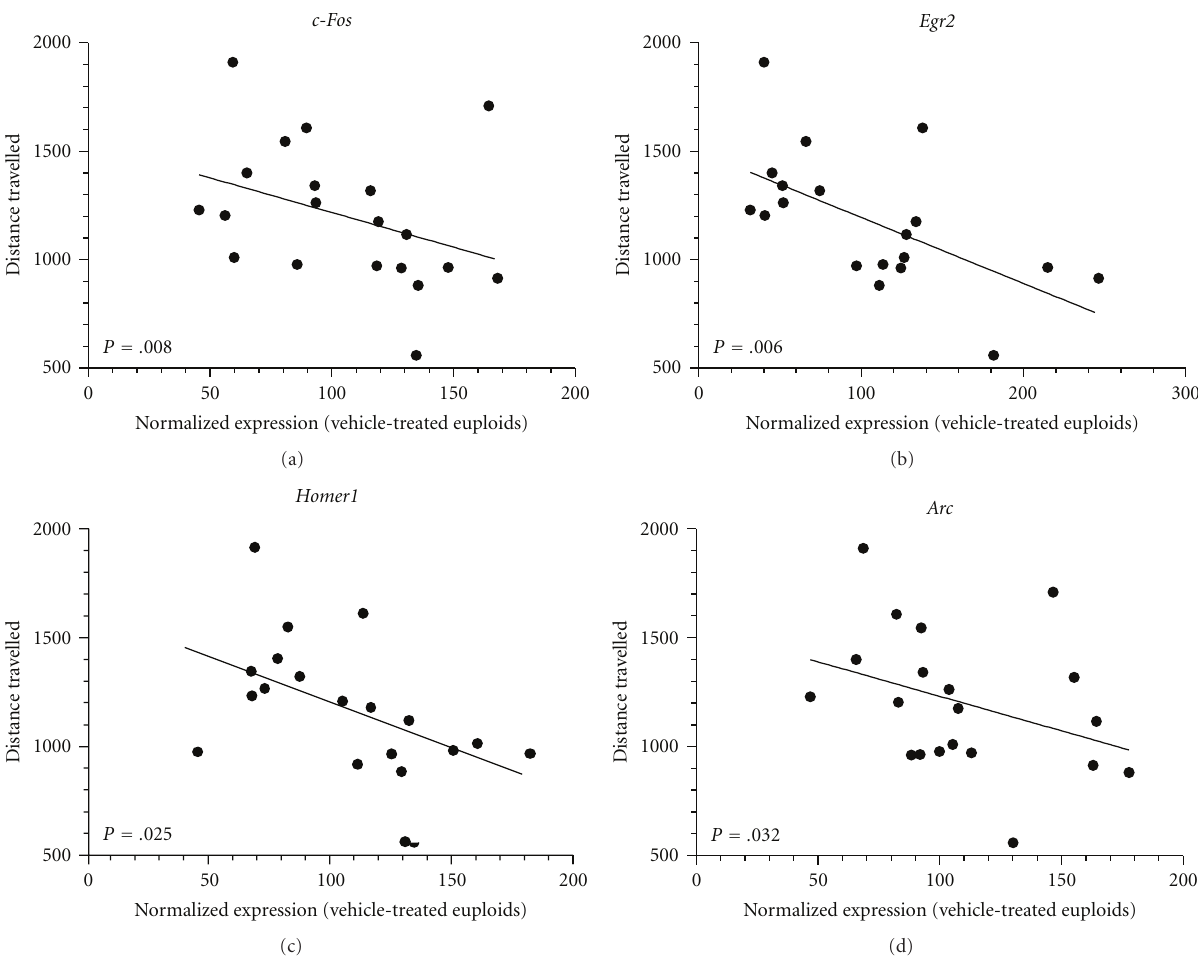
Figure 7: Correlation between IEGs expression levels and behavioral performances. Expression levels of IEGs were negatively correlated to the mean distance travelled during MWM testing ( − 0 . 645 < r < − 0 . 494, Pearson correlation) underlining a tight relationship between learning proficiency and IEGs